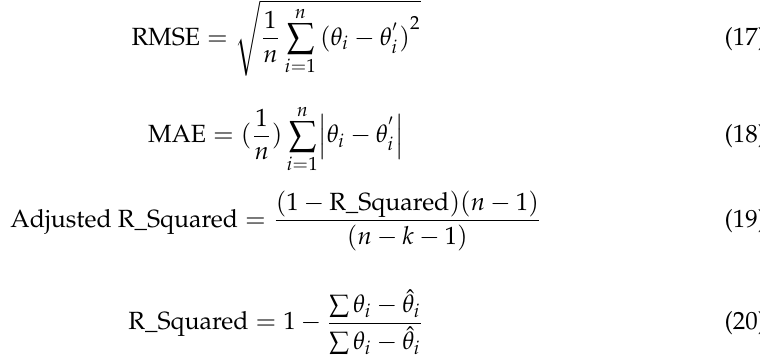
Table 3. The achieved RMSE values with our proposed transfer learning approach for building angle orientation estimation. Optimizer